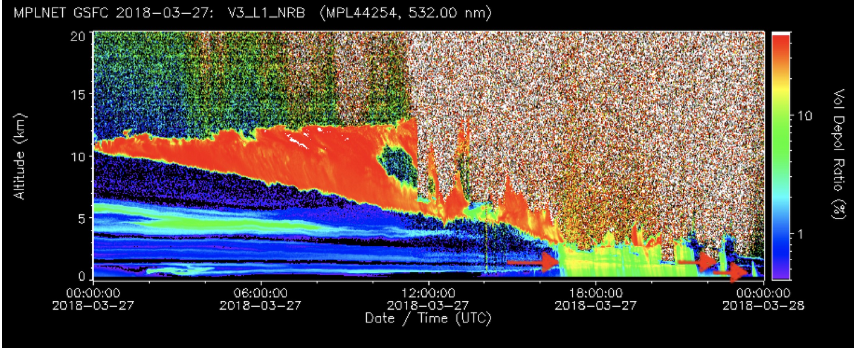
Figure 1. 27 March 2017 Micropulse lidar network (MPLNET) Version 3 Volume Depolarization Ratio (VDR) variable (L15 MPLNET Normalized Relative Backscattering (NRB) product). Red arrows highlight the starting point of the precipitation